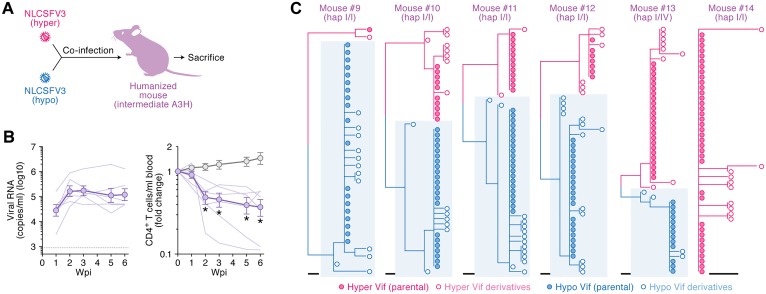
Dynamics of hyper/hypo HIV-1 infection in intermediate A3H humanized mice.(A, B) HIV-1 infection in humanized mice. (A) A schematic of co-inoculation of hyper and hypo HIV-1s into intermediate A3H humanized mice. (B) Hyper and hypo viruses containing 2.5 ng of p24 antigen each (5 ng in total; n = 6) or RPMI1640 (n = 12; for mock infection) were inoculated into humanized mice. The amount of viral RNA in plasma (left) and the level of peripheral CD4+ T cells (CD45+ CD3+ CD4+ cells) (right) were analyzed at 0, 1, 2, 3, 5, and 6 wpi as described in Materials and Methods. The averages are shown in circles with SEMs, and the values from each mouse are shown by line. X-axes, wpi. In the left panel, horizontal broken line indicates detection limit (800 copies/ml plasma). In the right panel, *P < 0.05 versus mock-infected mice by Mann-Whitney U test. (C) Phylogenetic trees of vif sequence. Viral vif sequences in the plasma of infected mice at 6 wpi were analyzed as described in Materials and Methods. Results of each infected mouse (mice #9–14) are respectively shown. Blue shadow indicates hypo vif derivatives. Scale bar represents one nucleotide substitution.